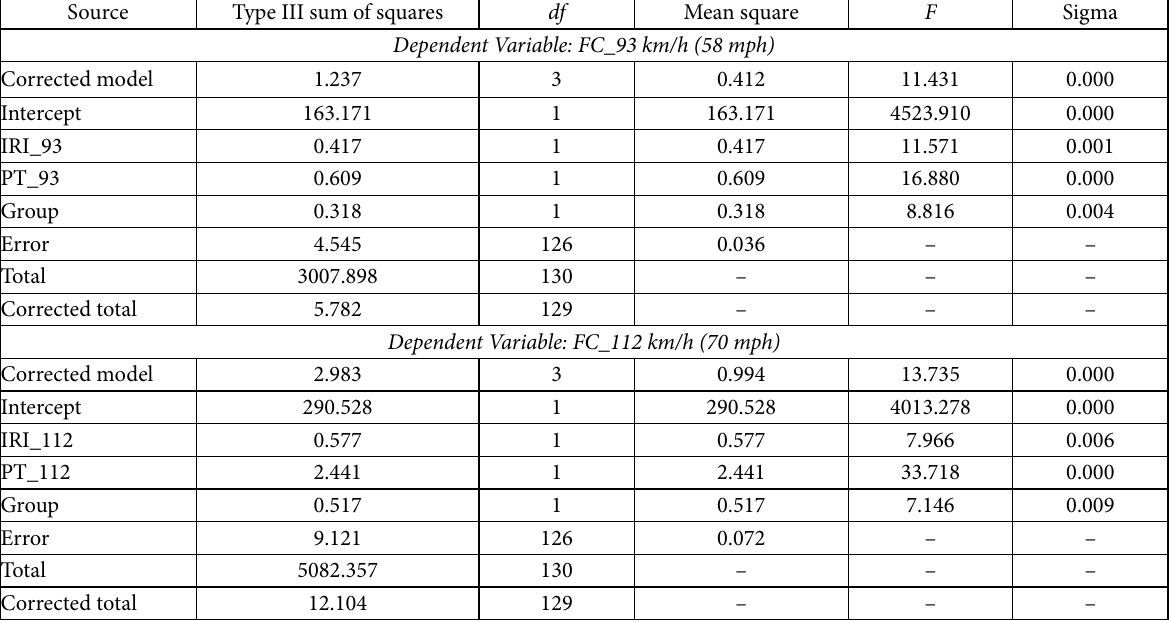
Table 2. Results of ANCOVA